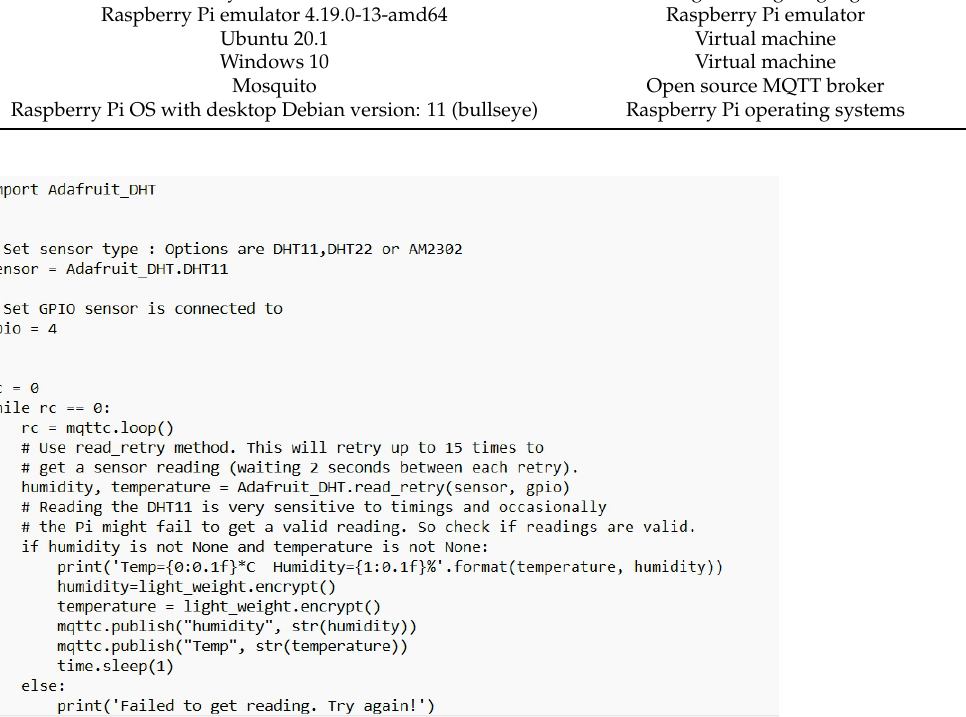
Figure 4. The Raspberry Pi emulator code for obtaining humidity and temperature readings from